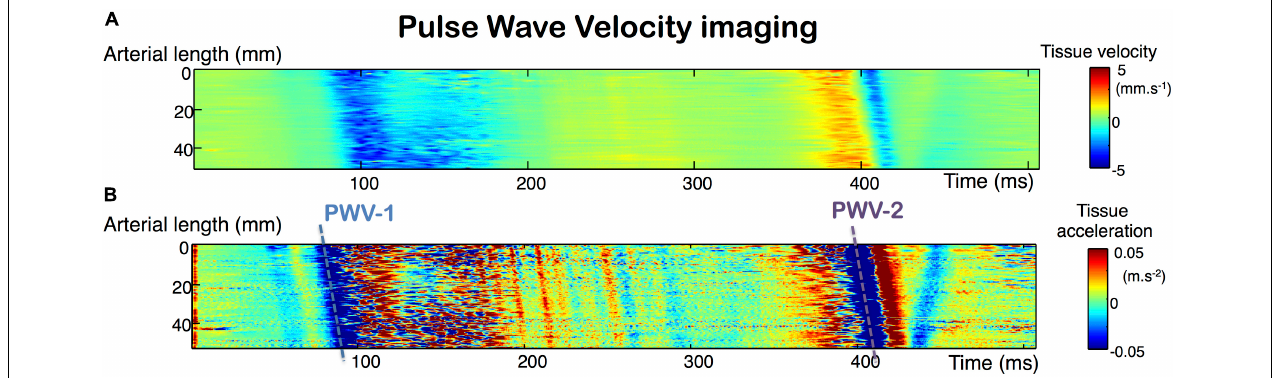
FIGURE 1 | Ultrafast tissue Doppler imaging along the arterial wall over the cardiac cycle. Analysis of the tissue Doppler velocities of the arterial walls over time provides access to pulse wave velocity (PWV) measurements (A) . The measurement is obtained by the automated calculation of the slope of the main tissue Doppler acceleration peaks (B)